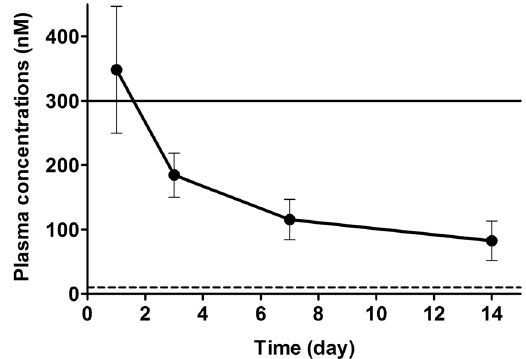
Figure 2. Plasma concentration of C-1 in mice after administration of sustained-release pellets of C1. Plasma concentrations of C-1 are shown as the mean with SD (n = 10). The upper solid line represents a concentration of 300 nM, at which C-1 did not show an agonistic activity for ER α in vitro . The lower dashed line represents a concentration of 10 nM, at which C-1 shows full agonistic activity equal to that of E2 for ER β in vitro .